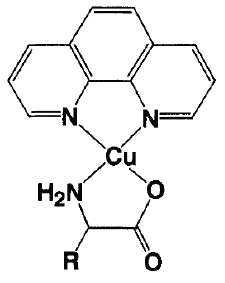
Figure 7. Ternary [Cu(phen)(AA)] + complexes with amino acids